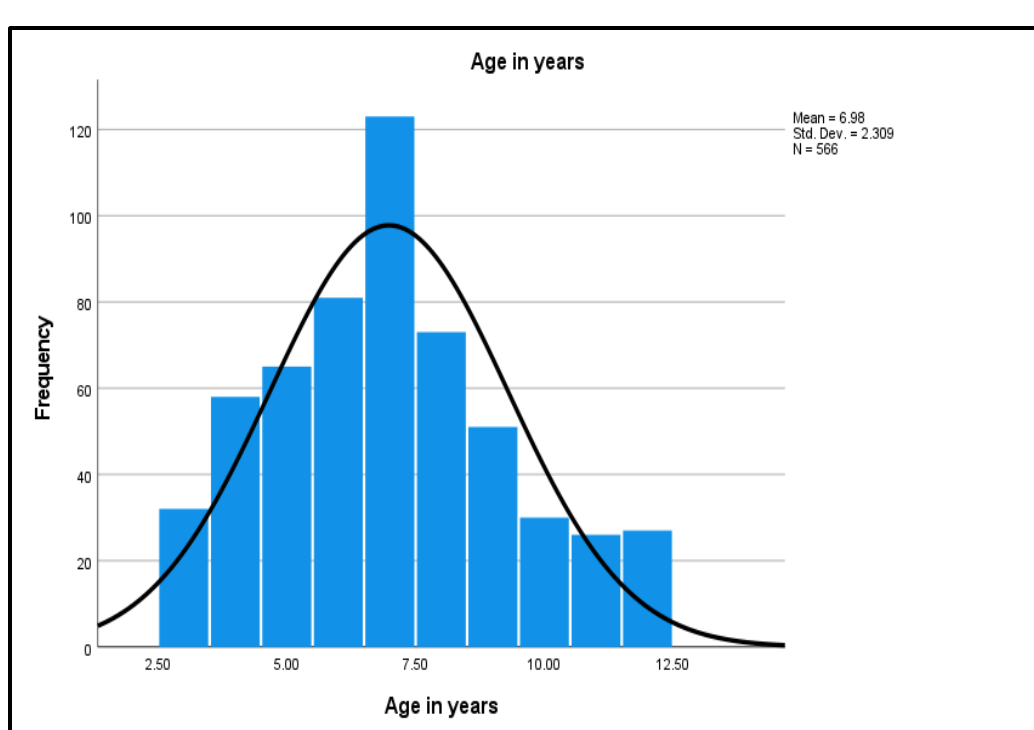
Figure 2. Normality Curve on the Age Distribution.